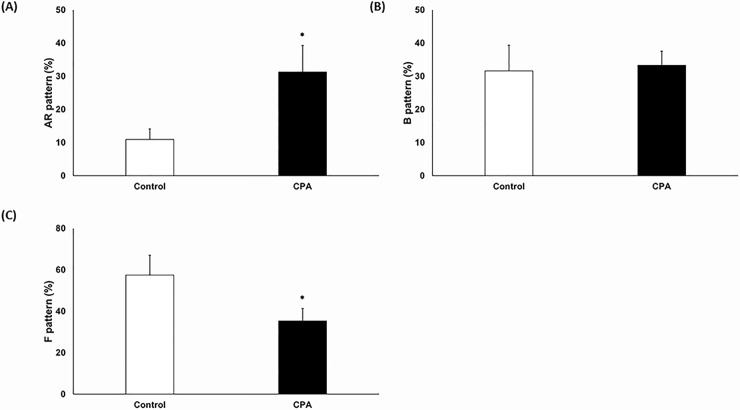
Effects of CPA addition on live sperm capacitation status as assessed by combined H33258 /CTC staining (A) AR pattern, (B) B pattern, (C) F pattern. Data are presented as the mean ± SEM. (*p < 0.05, n = 9).